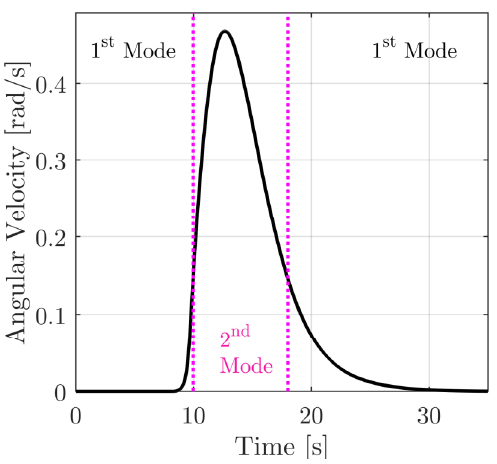
Figure 3. Angular velocity of the vehicle.